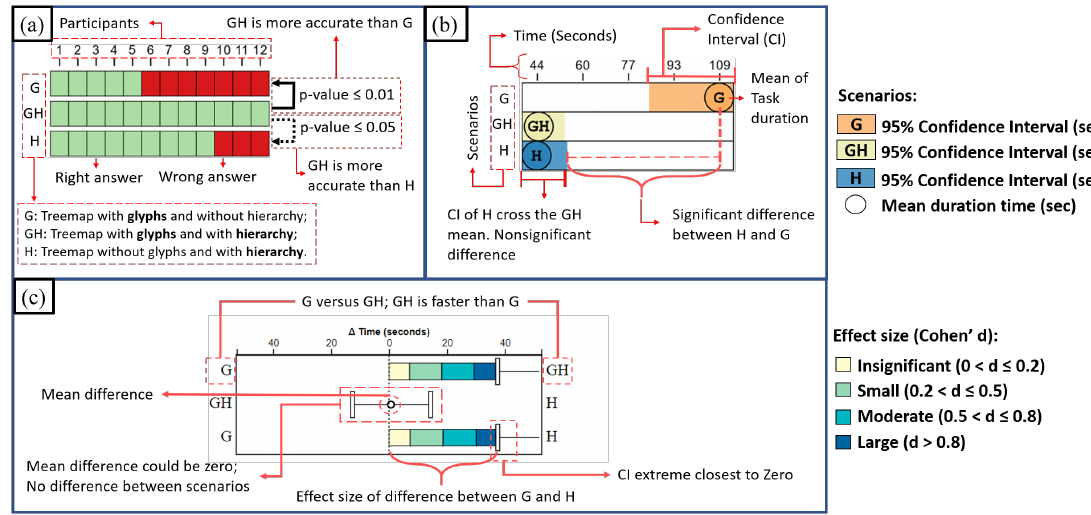
Figure 12. How to interpret the charts for the results of one task in the following sections. ( a )—Quantity of correct and incorrect answers and a pair-wise test using bootstrapping; ( b )—Mean response time with 95% confidence intervals; ( c )—Pair-wise time comparison using bootstrapping and Cohen’s d.